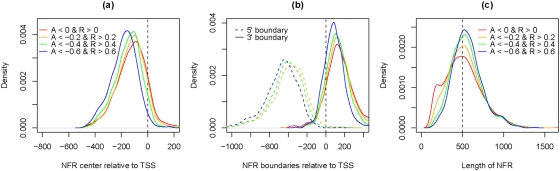
The distributions of locations and lengths of NFRs within promoter regions.NFRs that locate within 500bp upstream of ORFs were used and classified according to their DoND (A: absolute depletion, R: relative depletion). (a) The distributions of NFR positions (measured by the centers of NFR relative to TSSs) are plotted for NFRs with different DoND, as shown by curves with various colors. (b) The distributions of NFR boundaries (relative to TSSs) are plotted for NFRs with different DoND. The color codes are the same as in (a). (c) The distributions of NFR lengths are plotted for NFRs with different DoND.